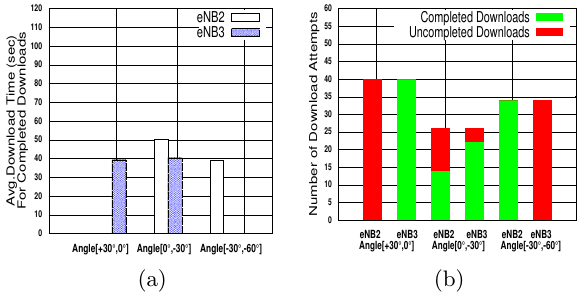
Figure 5: Average download time for completed downloads (a), Number of completed and uncom- pleted download attempts(b) vs range of